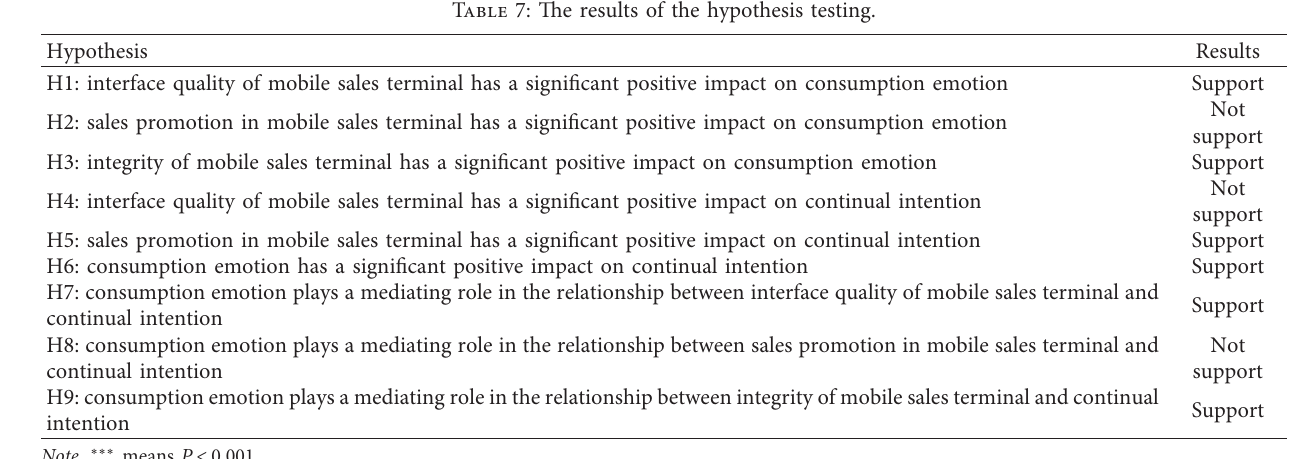
Table 7: The results of the hypothesis